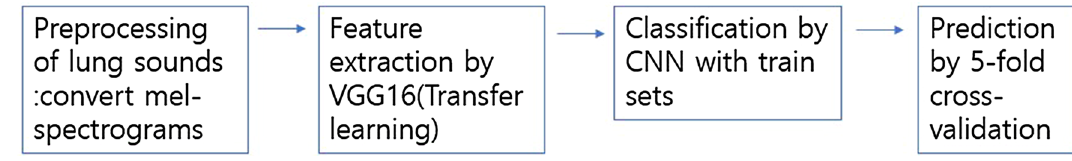
Figure 6. Overview of our AI models.